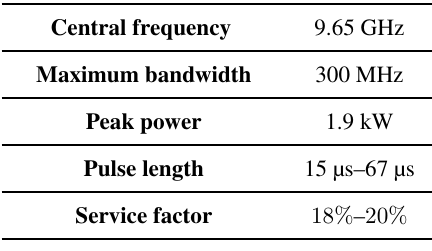
Table 2. PAZ signal parameters.